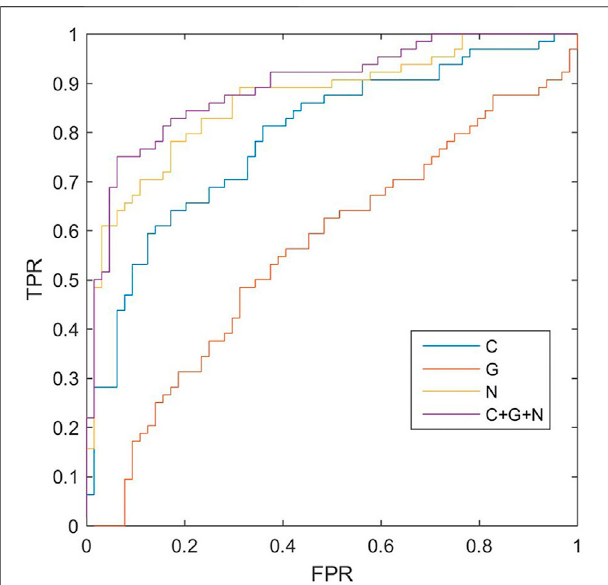
FIGURE 2 | The receiver operating characteristic (ROC) curve results of different methods. The ROC curve result indicate that the performances of information combination results are superior to those of single kernel methods. Additionally, the connection weights (C) + global metrics (G) + nodal metrics (N) method achieved the outperforming of results in all four measurements, demonstrating its effectiveness. Furthermore, according to DeLong ’ s nonparametric statistical signi fi cance test, the proposed C + G + N method (purple line) was found to be signi fi cantly superior to C, G, and